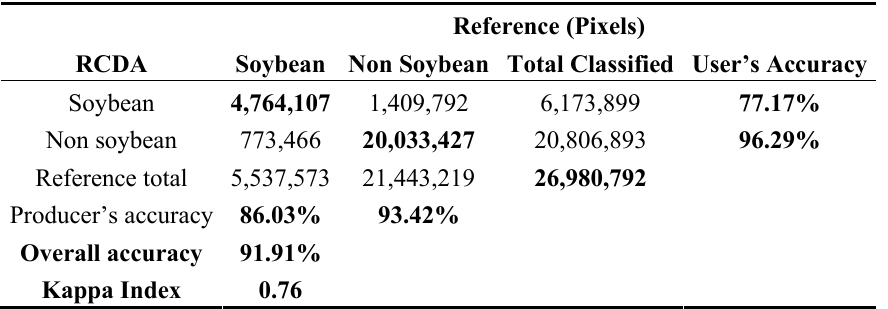
Table 2. Confusion matrix from the comparison of RCDA mapping and [3] mapping.